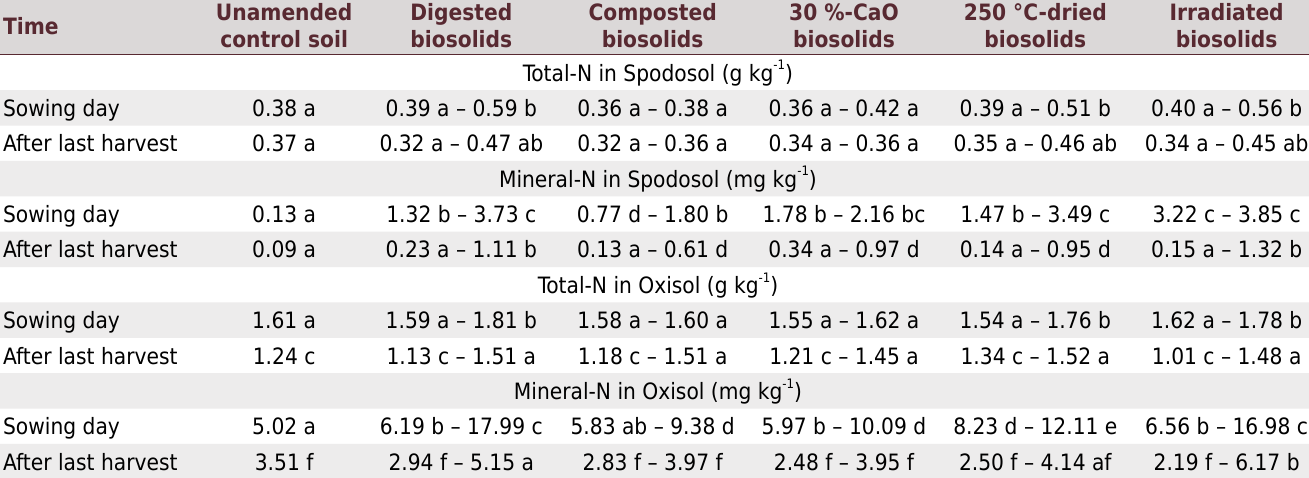
Table 4. Range of N concentrations in unamended soils and in soils at biosolids application rates of 0.25-8.0 dry Mg ha -1 on ryegrass sowing day and after the sixth-last